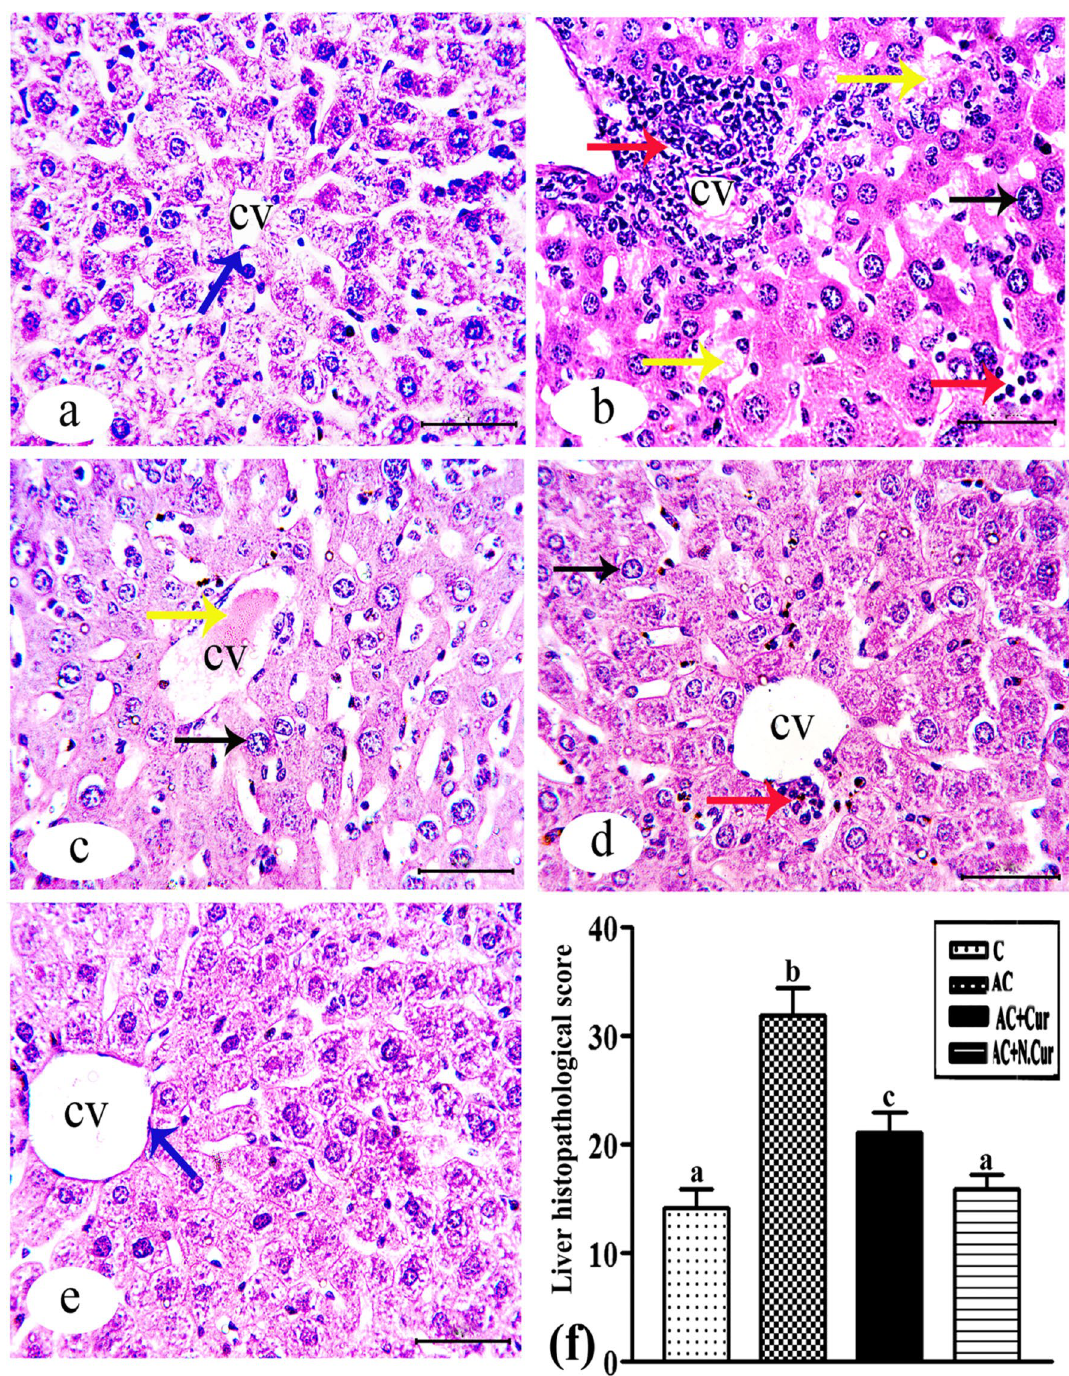
Figure 8. (a)–(e) Photomicrograph of H&E-stained liver sections from the indicated groups: (a ) control male mice, showing the central vein (cv) and obvious appearance of Kupffer cells (blue arrow); (b and c) AC group mice, revealing loss of hepatic architecture, hemorrhage (yellow arrow), inflammation (red arrow), fragmented nuclei (black arrow), multiple ballooned hepatocytes, and vacuolated cytoplasm; (d) : AC + Cur group , showing hepatic tissues with more modest cell infiltration (red arrow); (e) : AC + NCur group, demonstrating healthy architecture appearance similar to control (H&E Bar = 50 µm). (f) Liver histopathology scores of groups (mean ± SE) and values with different letters are significantly different ( p <